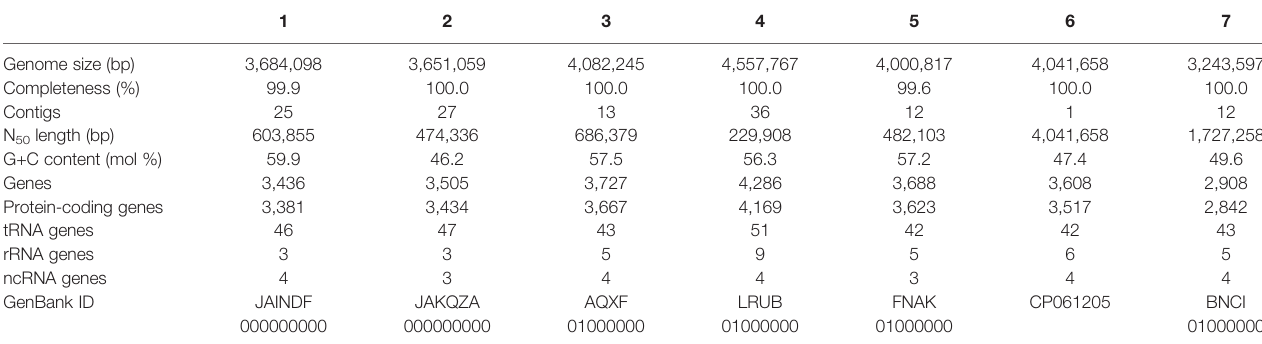
TABLE 3 | Genome statistics of strains A6E486 T and 5E331 T and fi ve members of the genus Kordiimonas . 1 Genome size